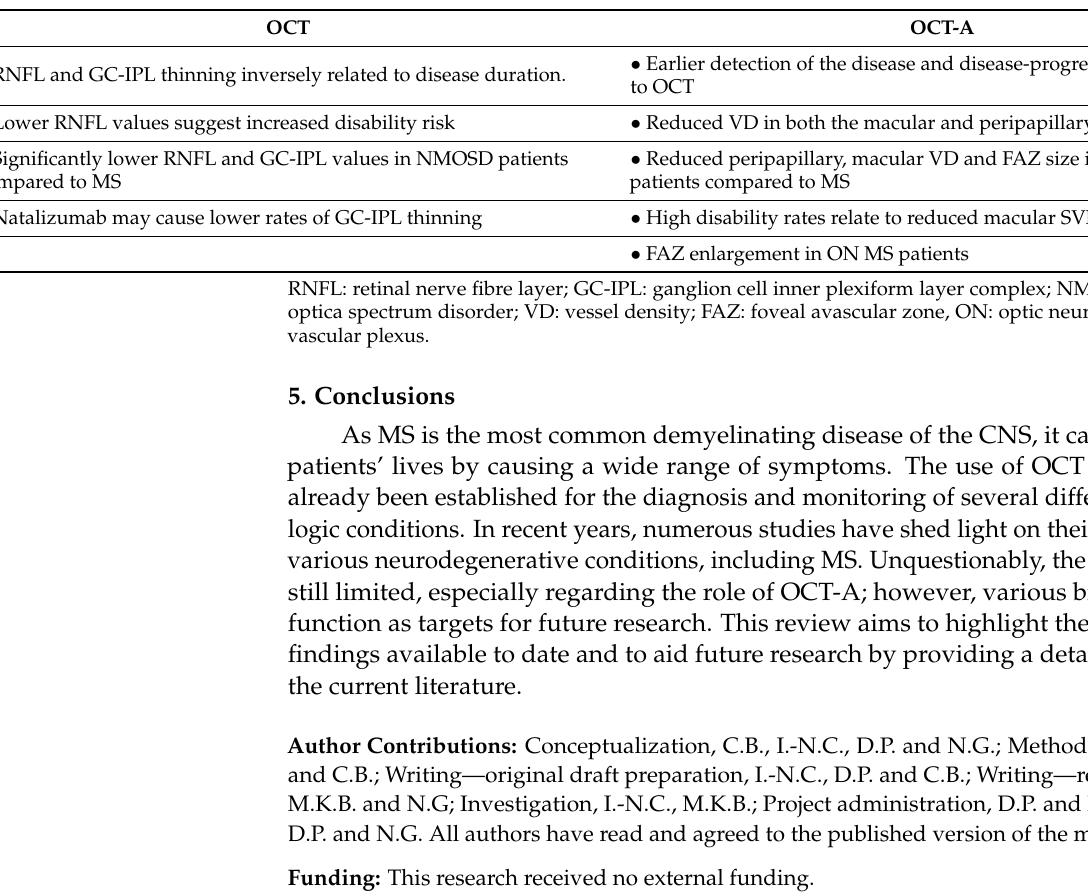
Table 1. OCT and OCT-A findings in